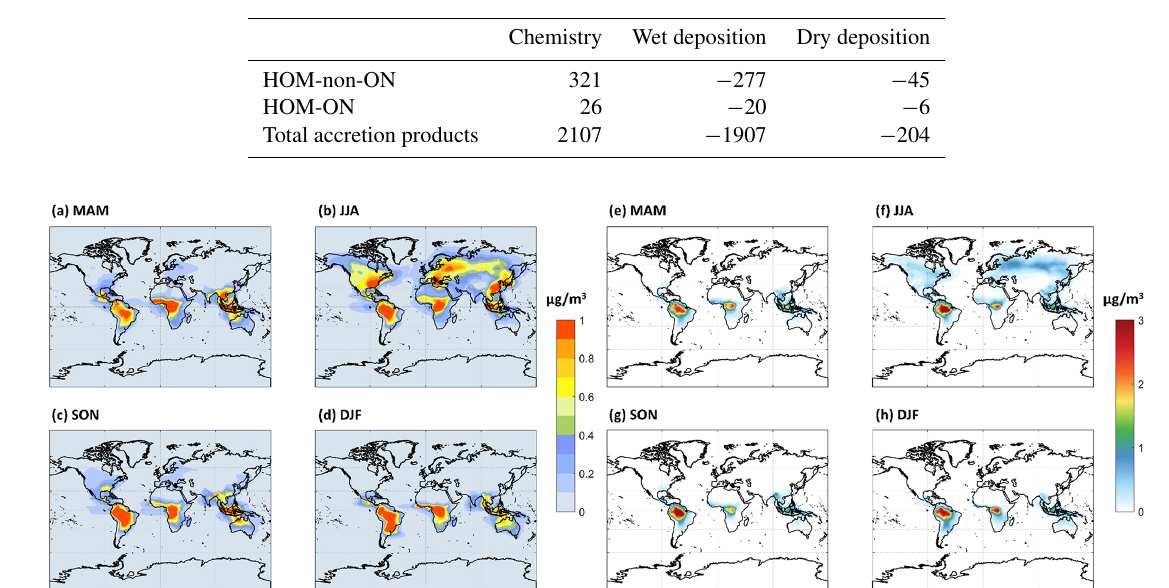
Figure 7. The seasonal PBL-averaged total HOM mass concentrations for (a) March–April–May (MAM), (b) June–July–August (JJA), (c) September–October–November (SON), and (d) December–January–February (DJF) from the LowProd_noPhoto experiment. Seasonal PBL-averaged total C 20 HOM accretion products are shown in panels (e) – (h) , assuming that HOM-RO 2 self- and cross-reactions produce accretion products at unit